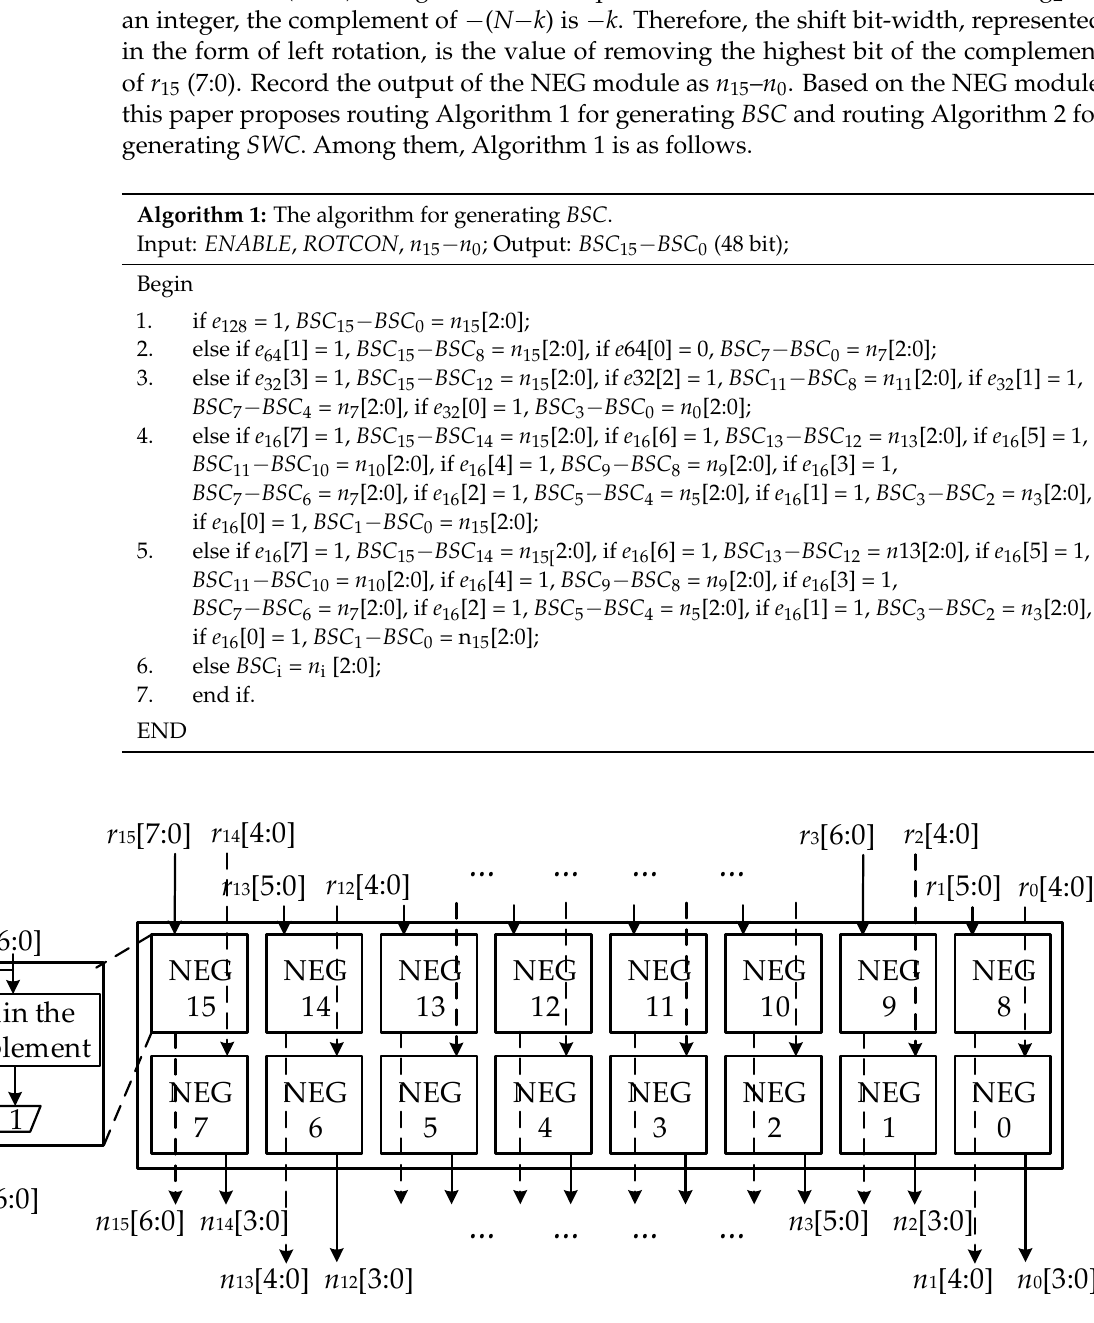
Figure 6. The circuit structure of the NEG module. Algorithm 1: The algorithm for generating BSC.